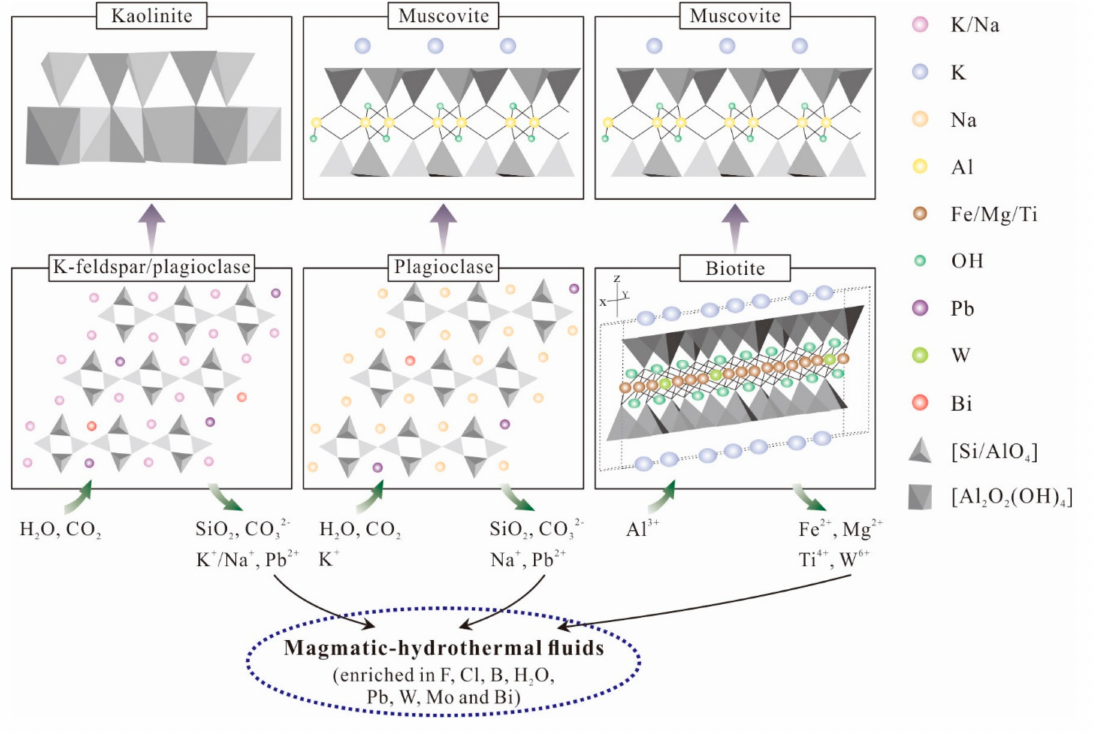
Figure 8. Alteration models for K-feldspar, plagioclase and biotite contributed to Pb, W, Mo and Bi mineralization of the Shizhuyuan W-polymetallic